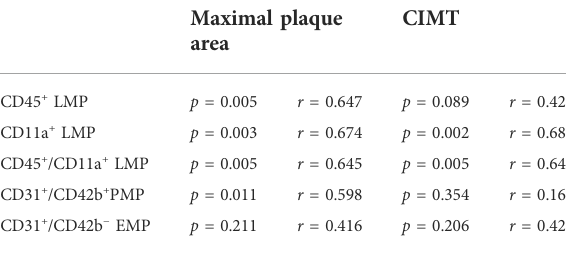
TABLE 2 Correlation analysis of fi ve microparticles with maximal plaque area and CIMT. Maximal plaque